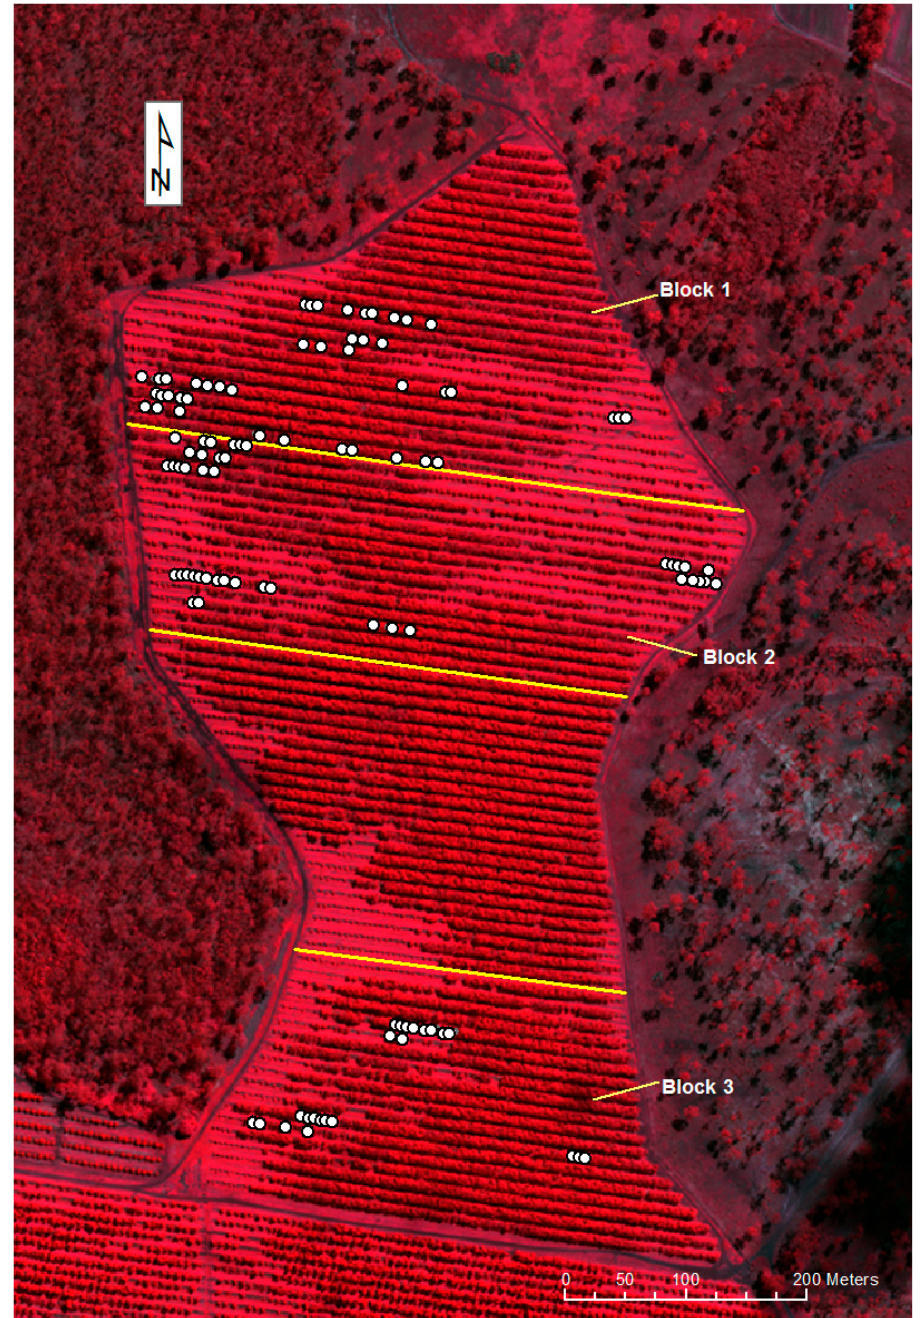
Figure 4. Worldview-3 satellite, false color image of the orchard with sample locations (acquired 3 April 2017). The location of selected trees is given as solid white circles. To evaluate the spectral responses from the sampled trees against PRR disease severity rankings, 18 vegetation indices described in Table 2 were calculated. These indices (Table 2) were selected on the basis of having being closely related to specific features of plant leaf physiology